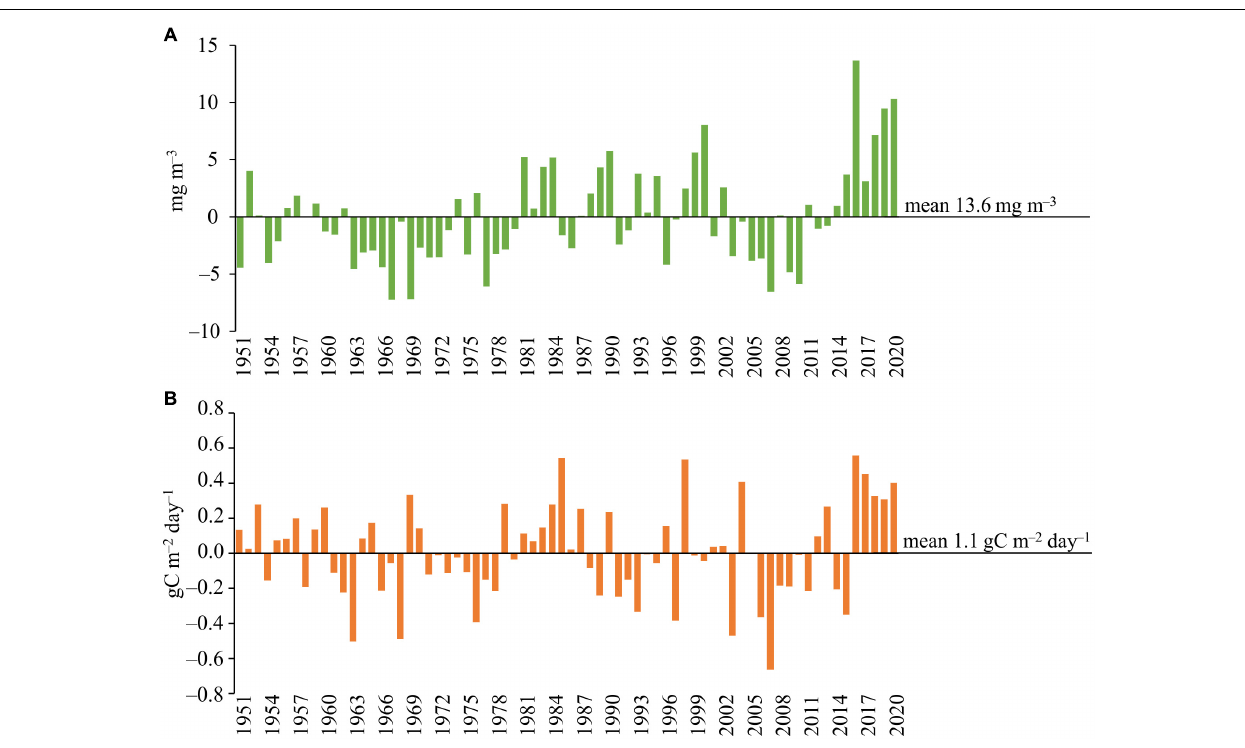
FIGURE 4 | Concentration of chlorophyll a (A) and plankton primary production (B) in the Neva Estuary in 1951–2020. Data for 1951–2002 calculated according to the obtained multi-regression dependences, data for 2003–2020 are obtained from field observations of the